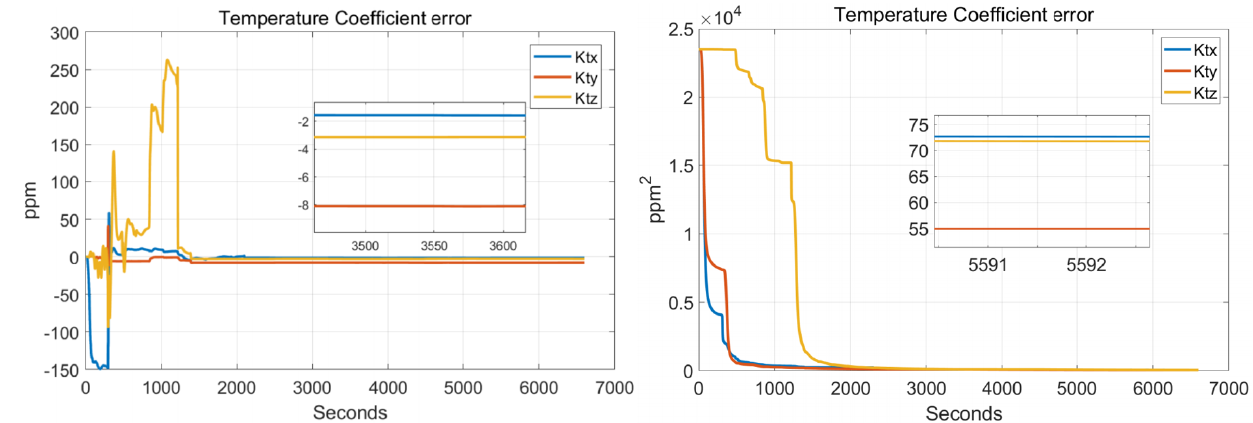
Figure 14. Temperature coefficient errors.